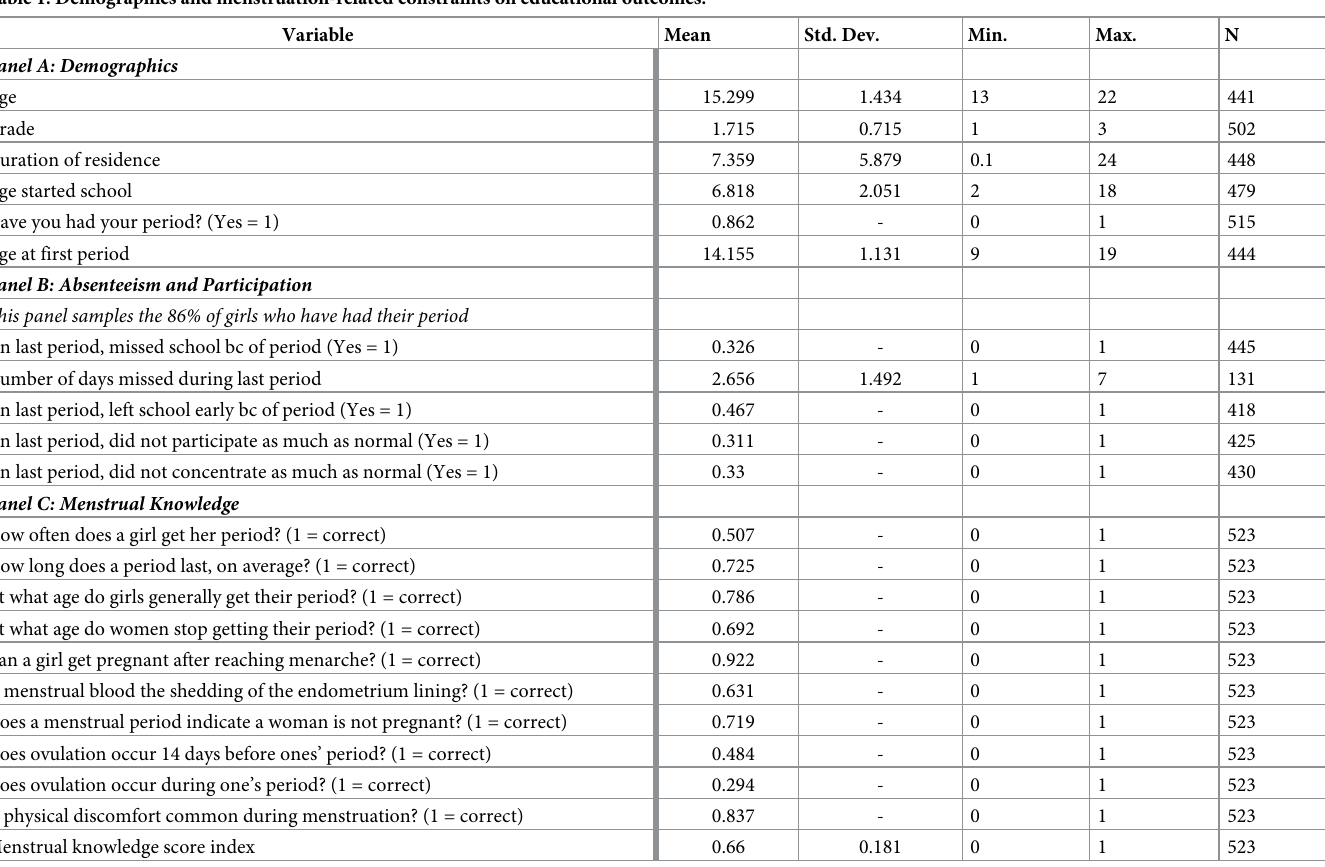
Table 1. Demographics and menstruation-related constraints on educational outcomes.